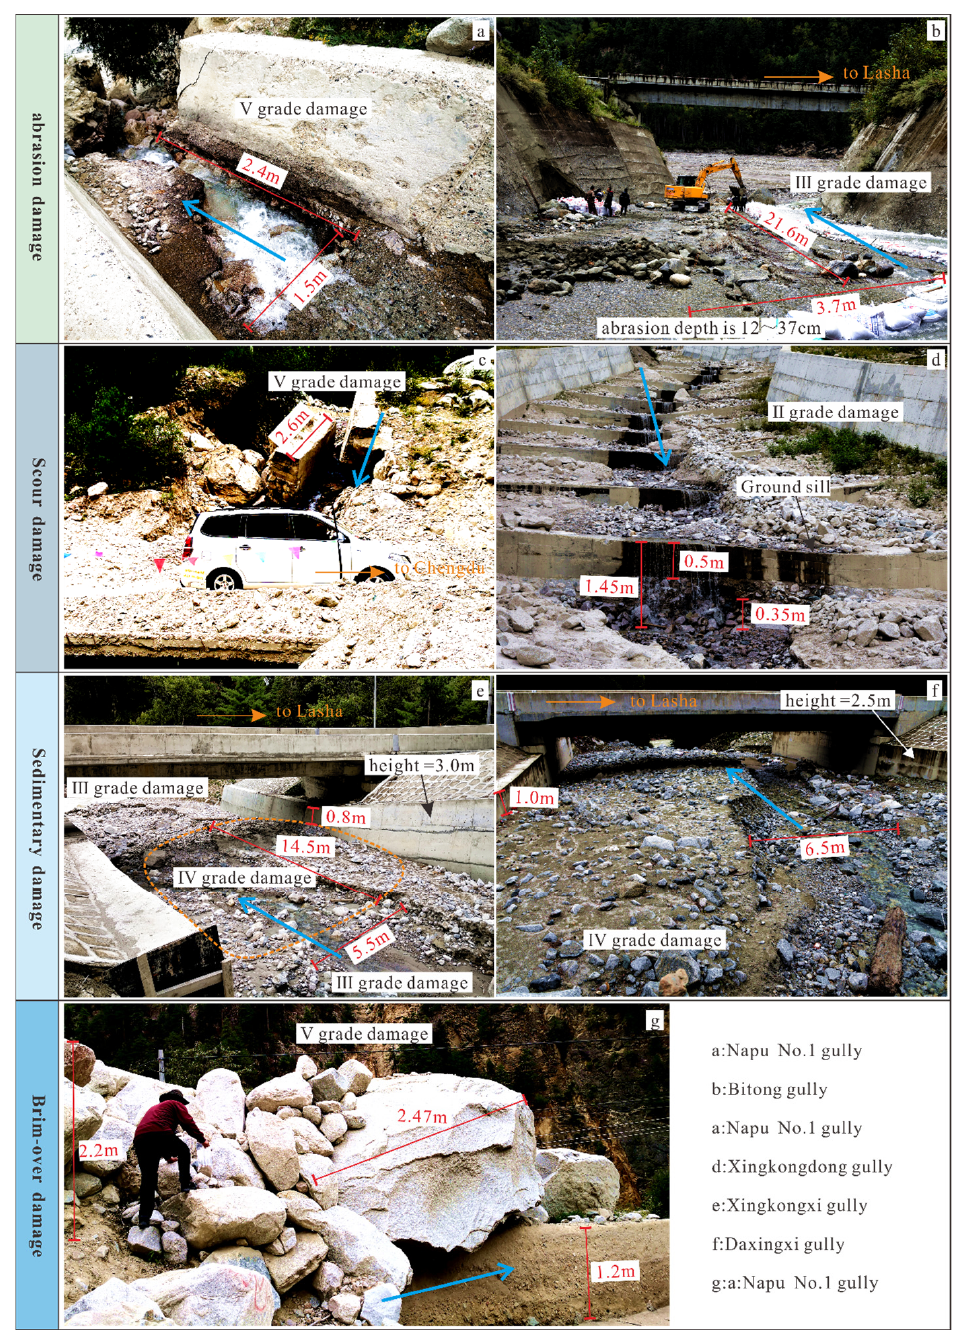
Figure 3. Damage types for drainage channels subject to glacial debris flow.